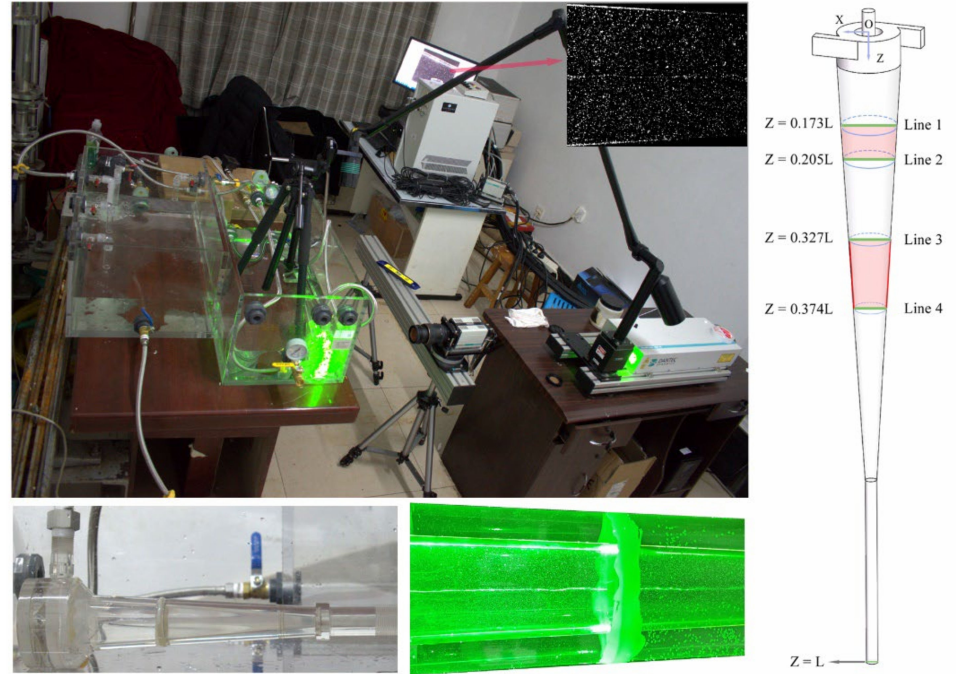
Figure 6. PIV experiment process and the selection of the location to be